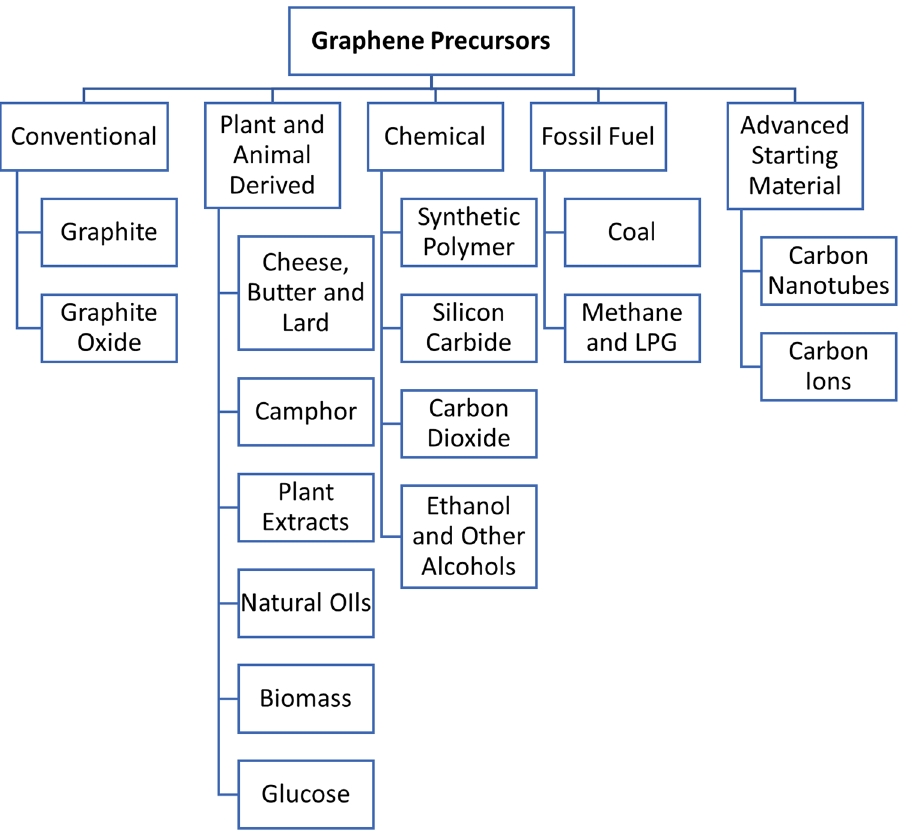
Figure 6: Potential precursors utilized for the generation of